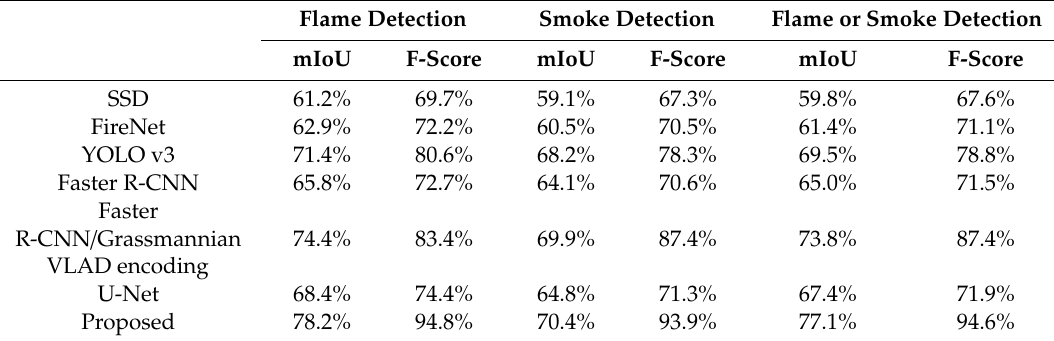
Table 2. Comparison